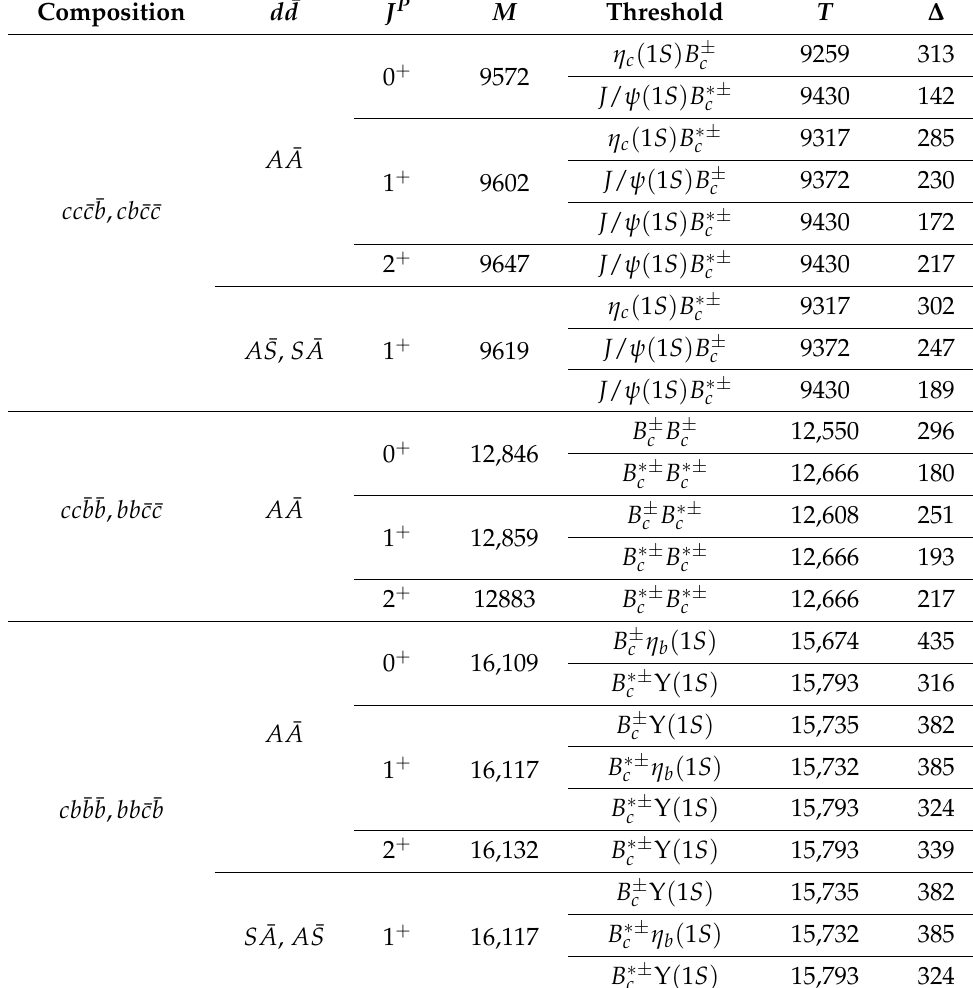
Table 11. Masses M of the charged heavy diquark–antidiquark states. T is the threshold for the decays into two heavy ( Q ¯ Q (cid:48) ) mesons and ∆ = M − T . All values are given in